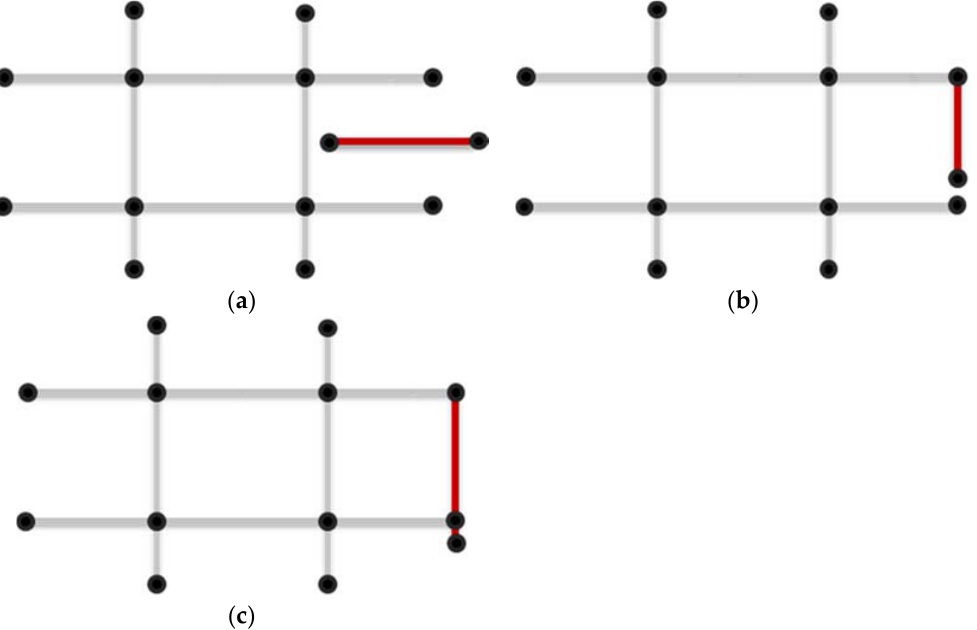
Figure 6. Three common types of topology errors. ( a ) Dangling arc, ( b ) Undershoot, ( c ) Overshoot.